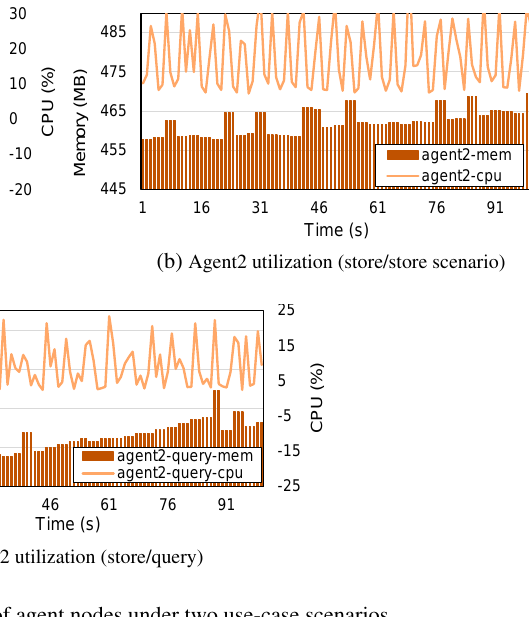
Fig. 6. Resource utilization of agent nodes under two use-case